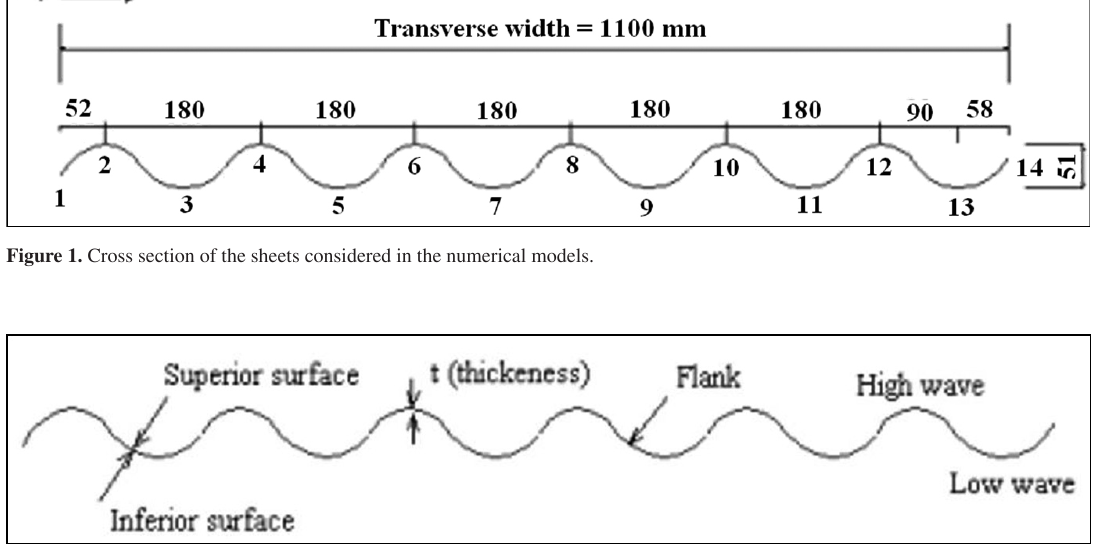
Figure 2. Nomenclature used for the corrugated